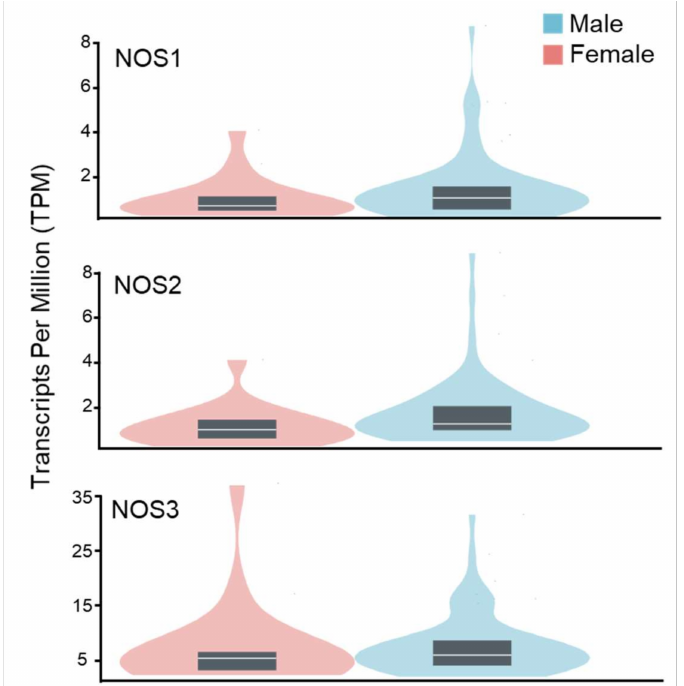
Figure 3. Genotype-tissue expression data for NO synthases in the human kidney cortex of males and females. Data were obtained from the GTEX portal (dbGaP Accession phs000424.v8.p2, 12 May 2022). Sample size: female n = 19; male n =